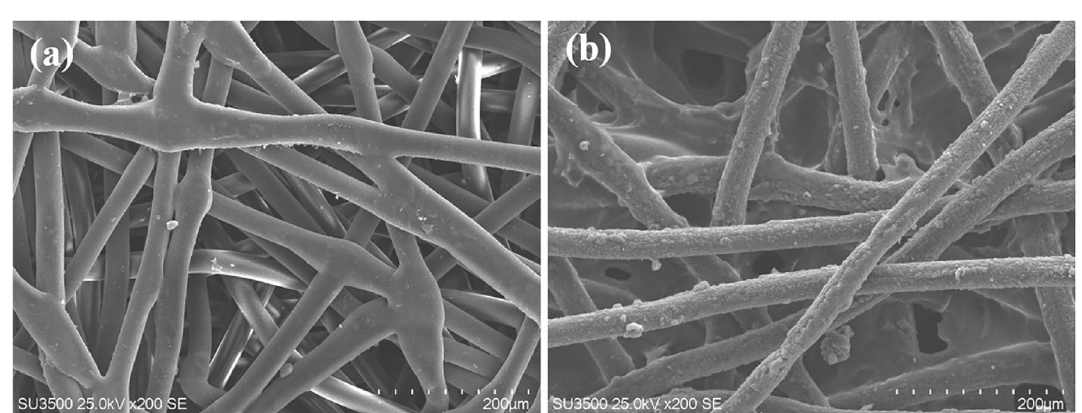
Figure 4. SEM images of ( a ) PP-nonwoven fabric; ( b ) amine group modified PP-g-(GMA-co-H 2 PO 3